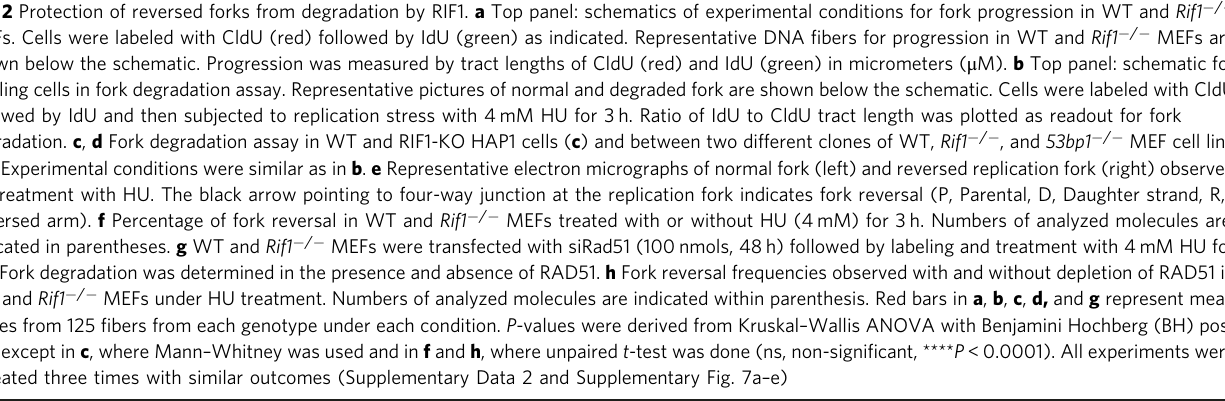
test except in c , where Mann – Whitney was used and in f and h , where unpaired t -test was done (ns, non-signi fi cant, **** P < 0.0001). All experiments were repeated three times with similar outcomes (Supplementary Data 2 and Supplementary Fig. 7a